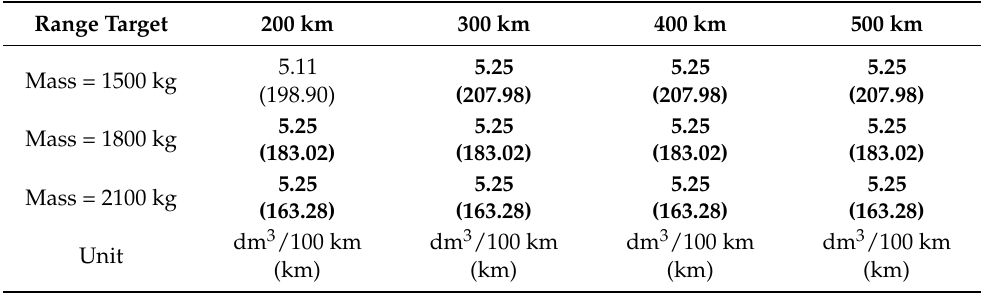
Table A13. Fuel consumption in EREV mode for constant speed drive at 120 km/h.